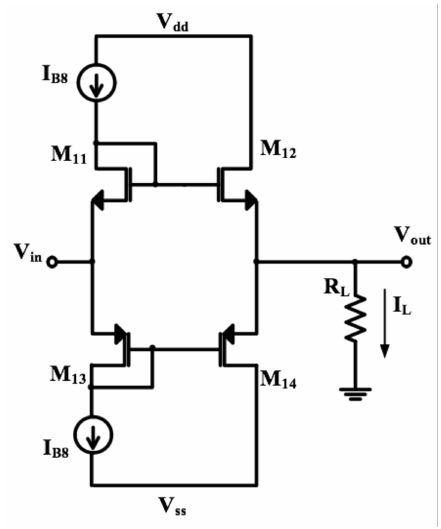
Figure 4. Conventional class AB voltage buffer